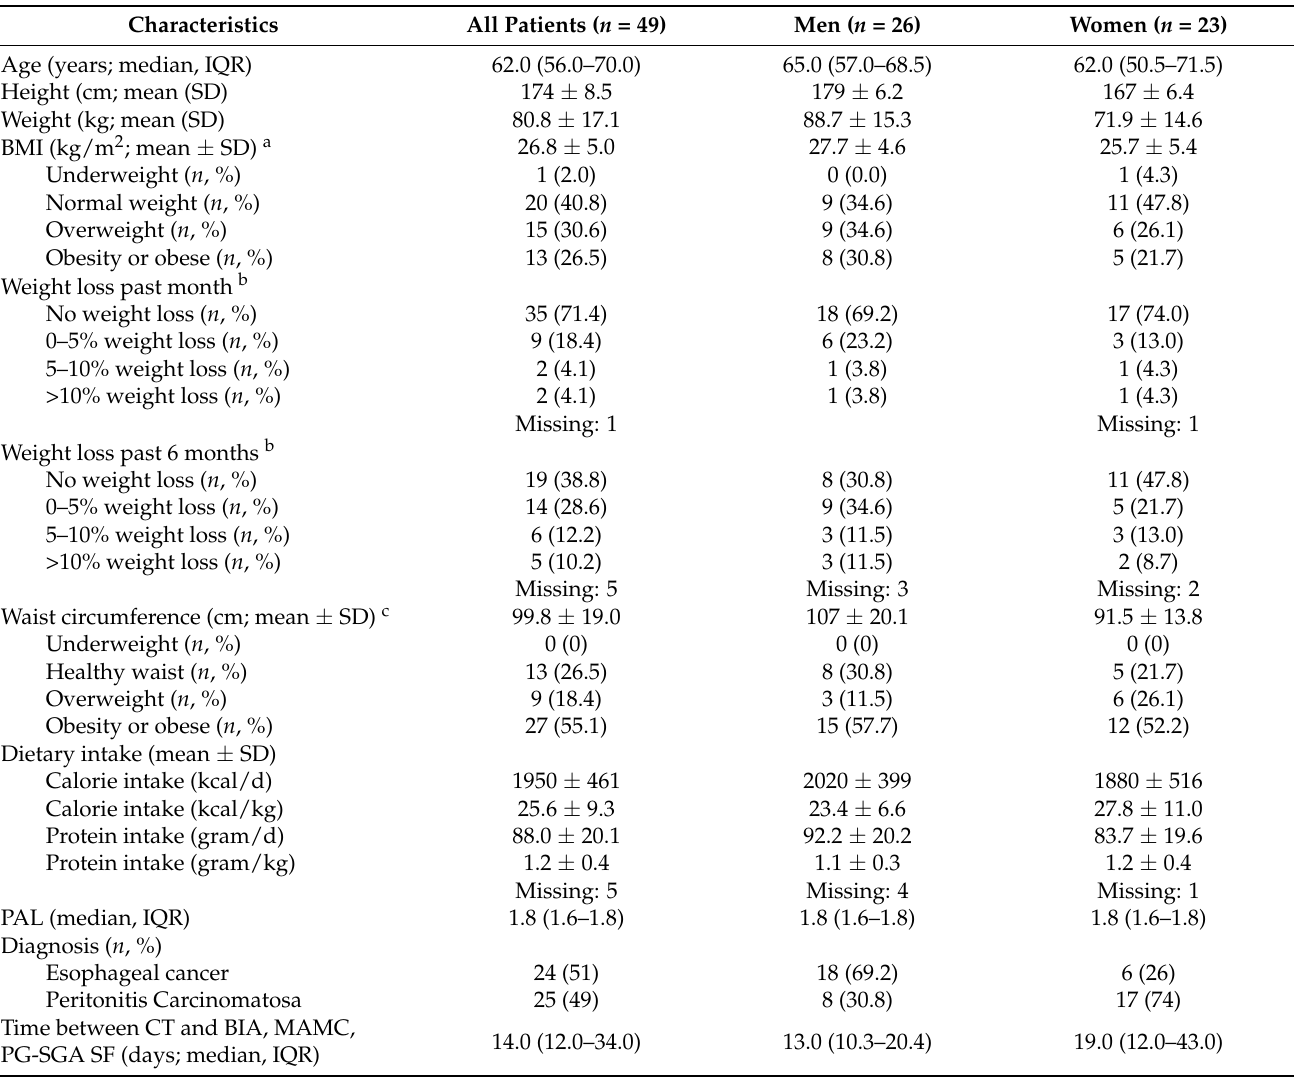
Table 1. Clinical characteristics of patients.